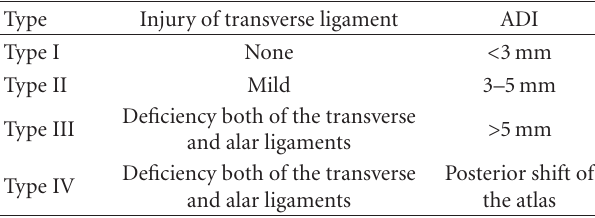
Table 1: Classification of AARD by Fielding and Hawkins [6].